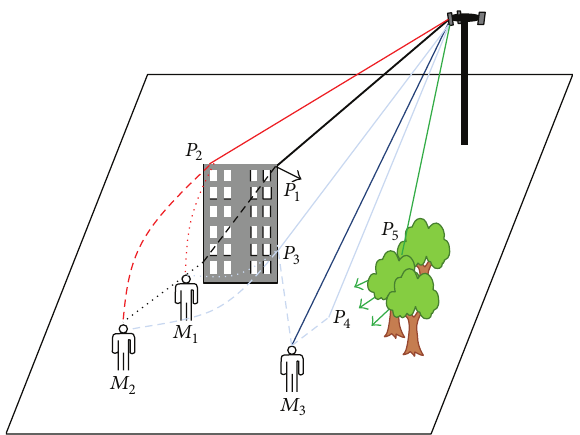
Figure 1: Representation of the main propagation mechanisms in a complex environment: LOS, reflection, diffraction, absorption, and